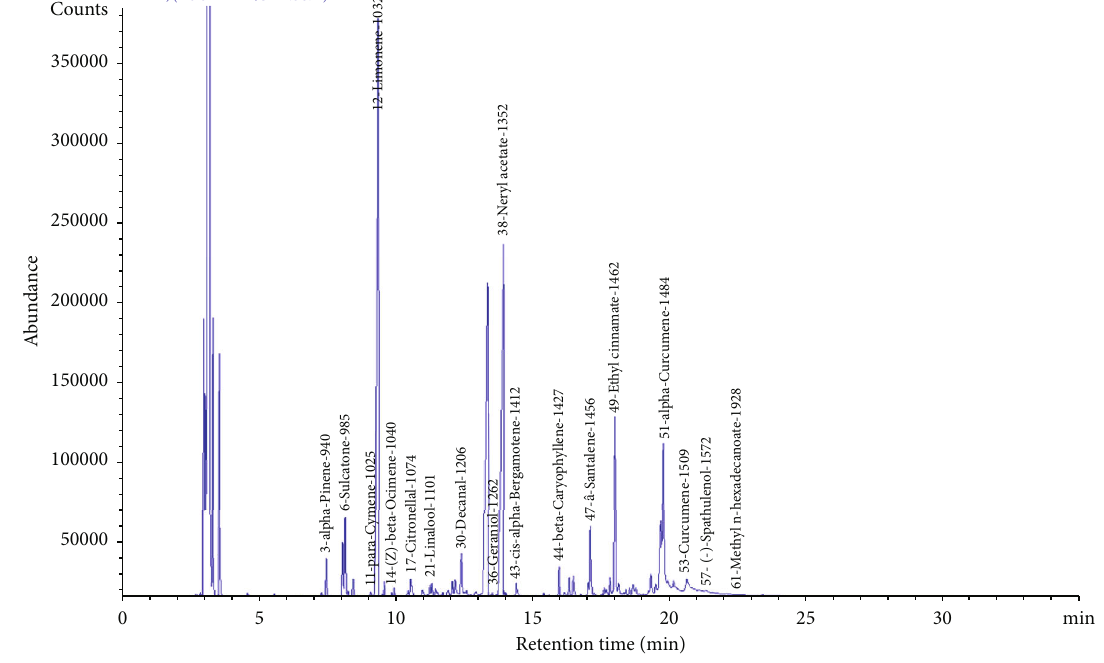
Figure 1: Chromatogram of Citrus limon peel essential oil components. Table 2: Observed responses for the four-component D-optimal mixture